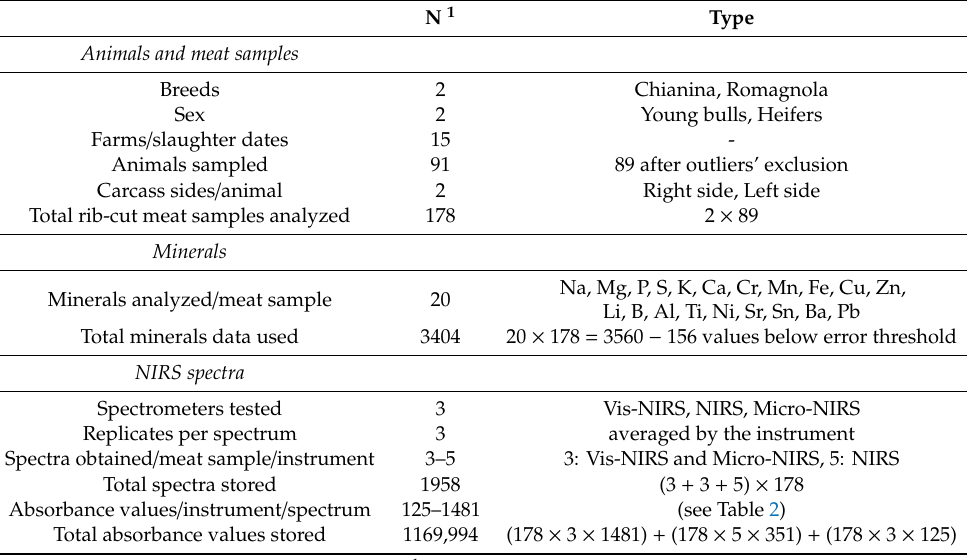
Table 1. Experimental design.